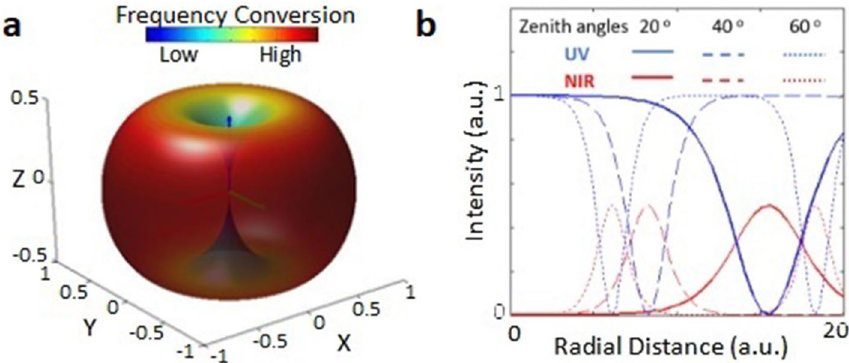
Figure 3. Non-linear interaction of waves leading to interconversion of UV and NIR from a single point of emission in the infinite material ( a ) Angular part of the strength of non-linear frequency conversion for w-GaN, ( b ) Numerical solutions showing intensity (of UV and NIR) vs radial distance travelled by a wave from the point of emission within the material at three specific zenith